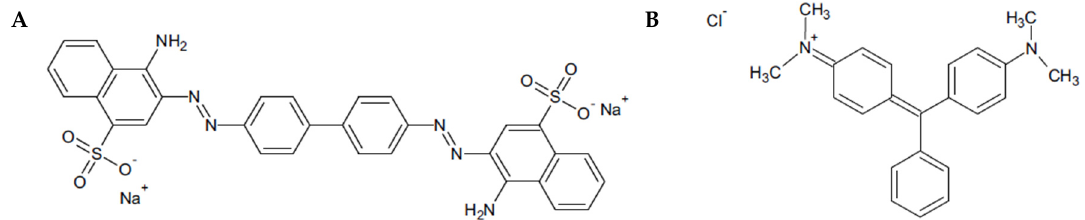
Figure 1. Chemical structure of the Congo red ( A ) and malachite green ( B ) dyes.